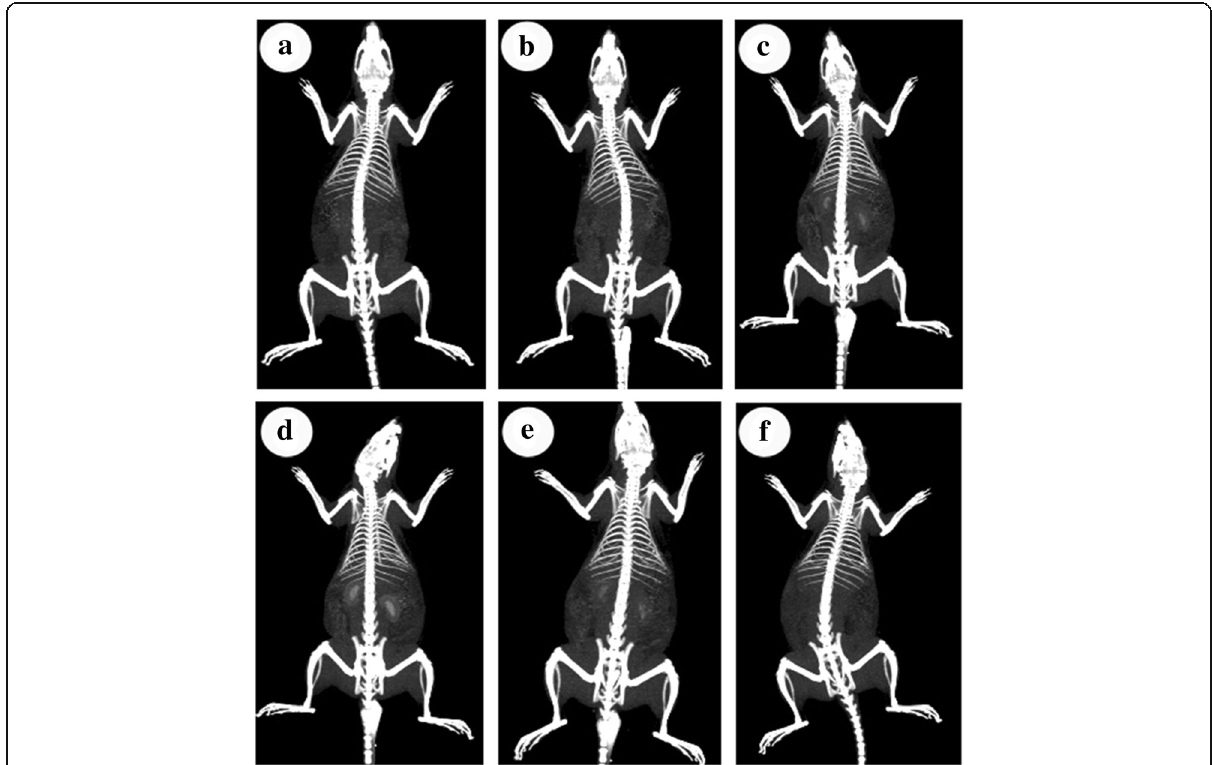
Fig. 4 CT images of rat before injection ( a ) and at different time points (0.5, 1, 2, 6, and 24 h) ( b – f ) after intravenous injection of AuNS@PEG nanoparticles (200